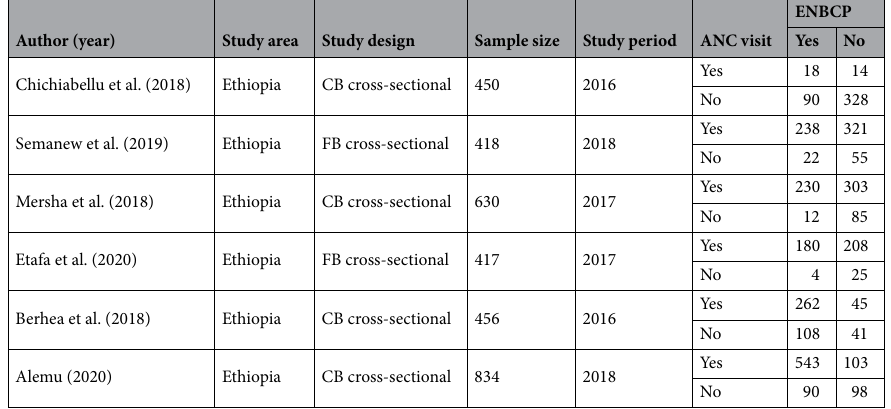
Table 2. Characteristics of studies included to study the effect of ANC visit on essential newborn care practice in East Africa.